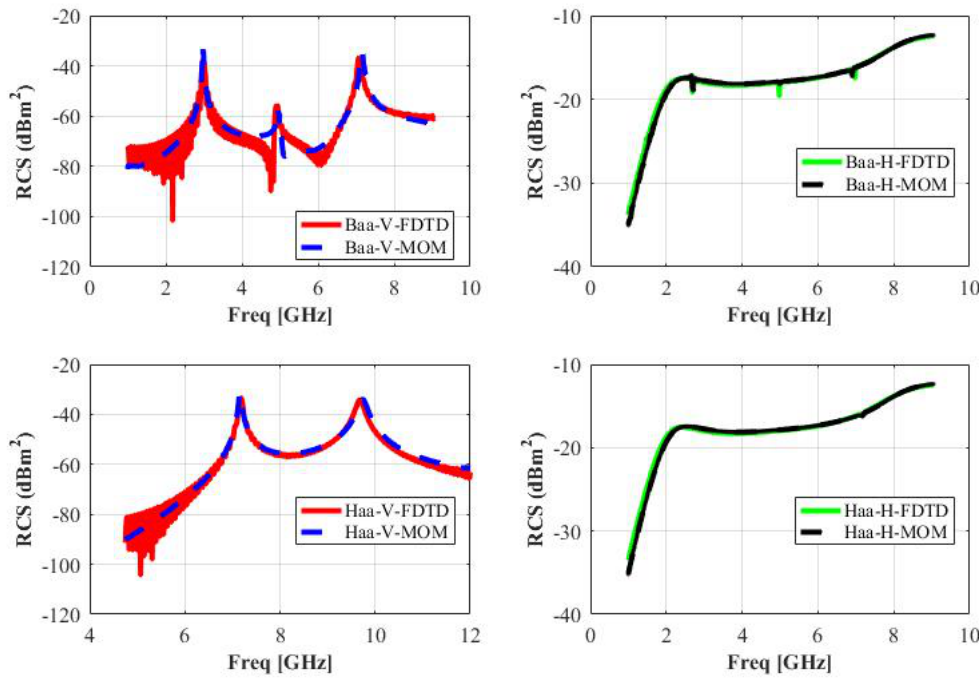
Figure 8. Comparison of RCS characteristics of letters H. and Ł using FDTD and MoM techniques.